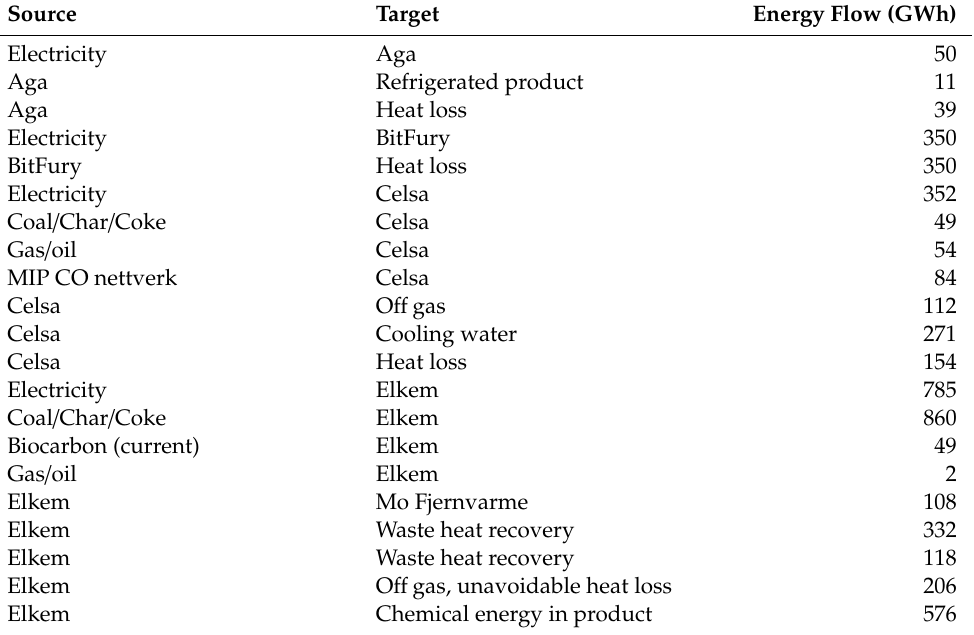
Table A3. Aggregated data on energy flows between companies within MIP. This table is the basis for construction of Sankey diagrams in Figure 3 (excluding the bottom three